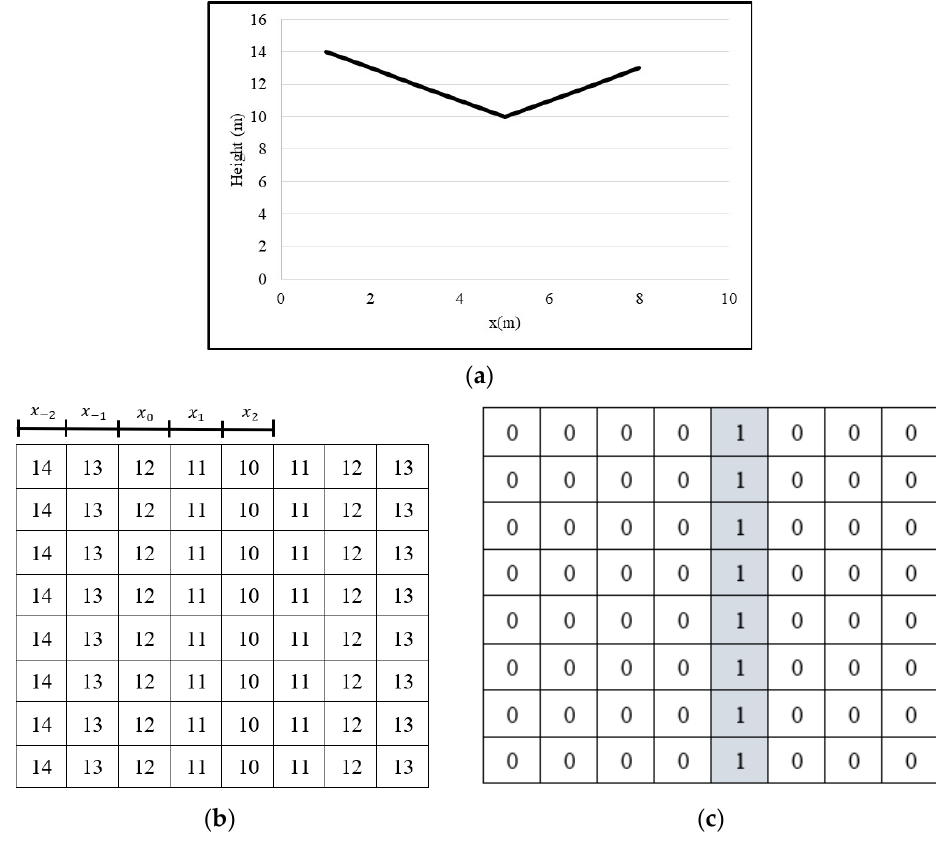
Figure 2. Obtaining a low ridge: ( a ) hypothetical butterfly roof, ( b ) linear morphological structuring element and heightmap of a blob, and ( c ) binary map of a low ridge.